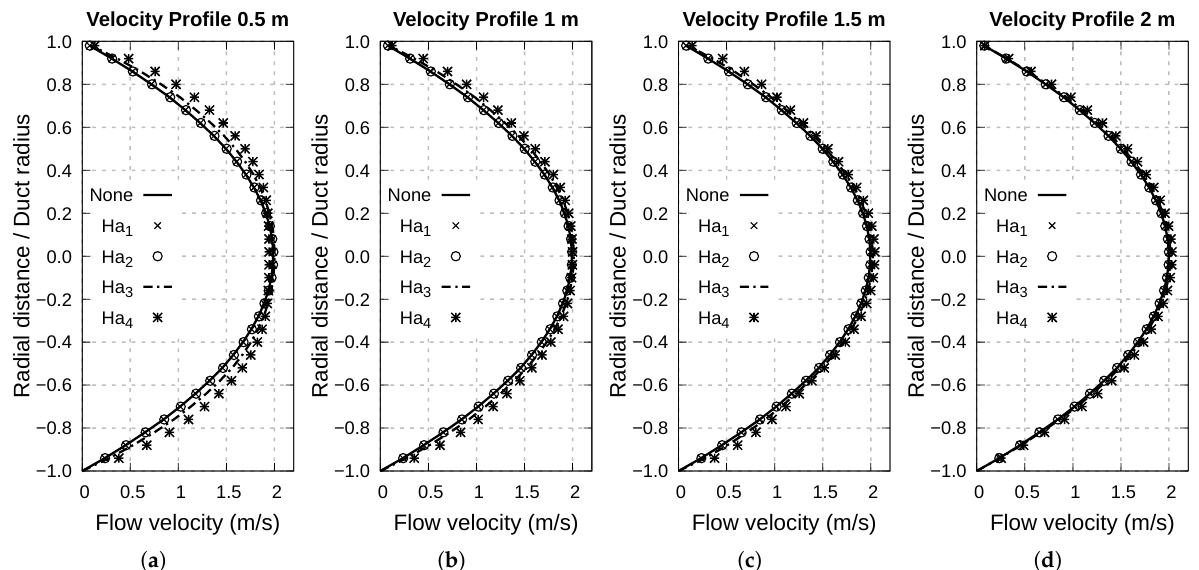
Figure 10. Velocity profiles of fluid flow in the duct at the positions ( a ) 0.5 m, ( b ) 1.0 m, ( c ) 1.5 m and ( d ) 2.0 m. Magnets are in the attractive configuration.